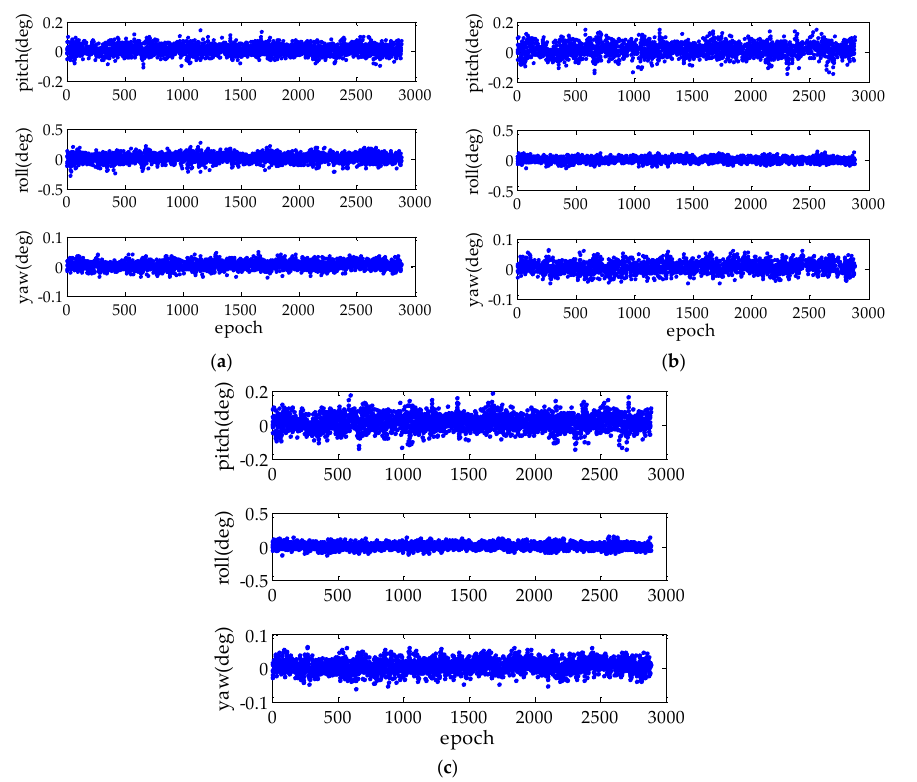
Figure 4. AD error comparison in static experiment: ( a ) is the FAR-PAD method; ( b ) is the FAR-MAD method; and ( c ) is the PAR-MAD method.